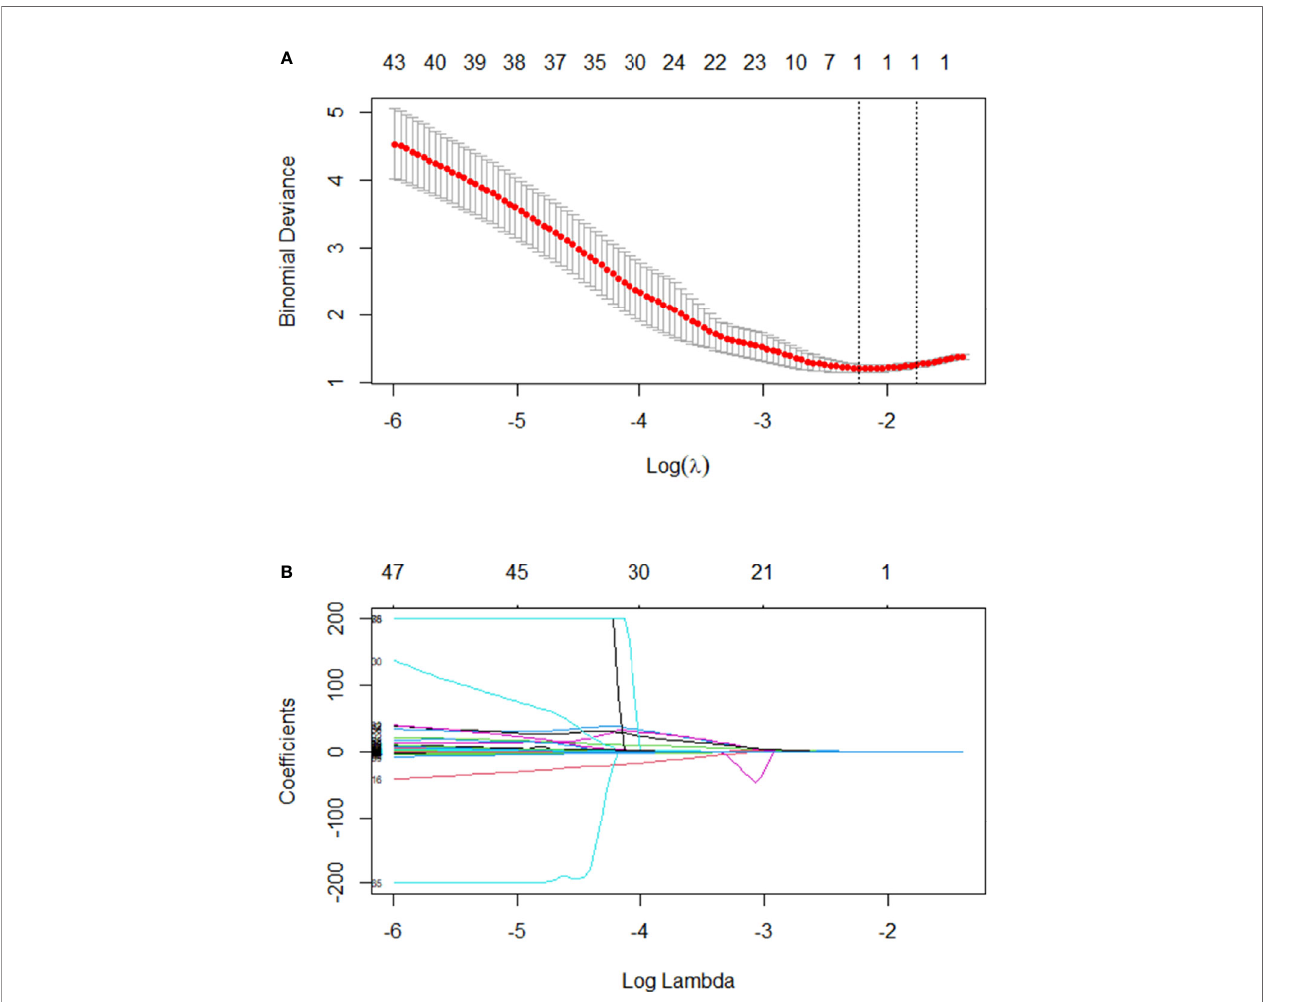
FIGURE 2 | (A) Text features were selected by the LASSO regression model. The performance of the radiomics signature was assessed by the ROC curve and C- index. Tuning parameter ( l ) selection used ten-fold cross-validation via the minimum criteria. The optimal value was calculated by the minimum criteria and the 1- standard error of the minimum criteria (the 1-SE criteria). A l of 0.1782 with log( l ) - 1.75562 was chosen. (B) A LASSO coef fi cient pro fi le plot was produced against the log( l ) sequence. In addition, one radiomics feature was